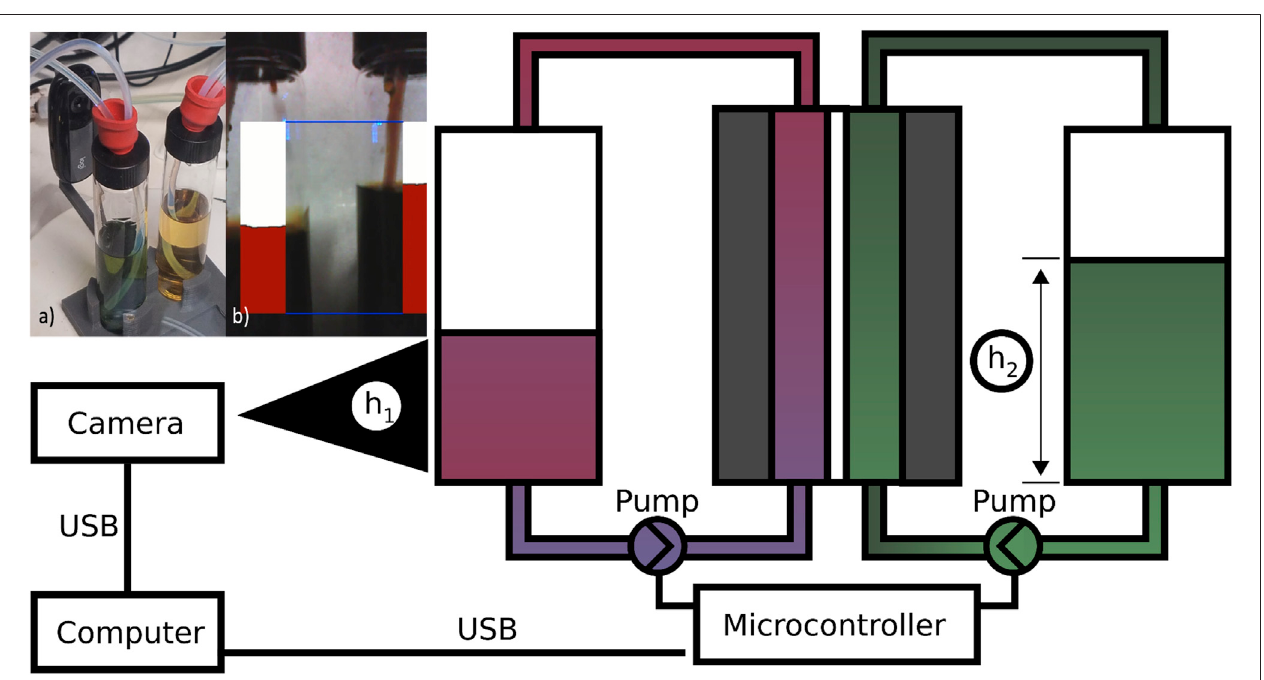
FIGURE 1 | Overview of experimental setup for active balancing of electrolyte volumes in fl ow battery reservoirs. Pictures of (A) the experimental setup and (B) the level sensing image processing script during a fl ow battery experiment.